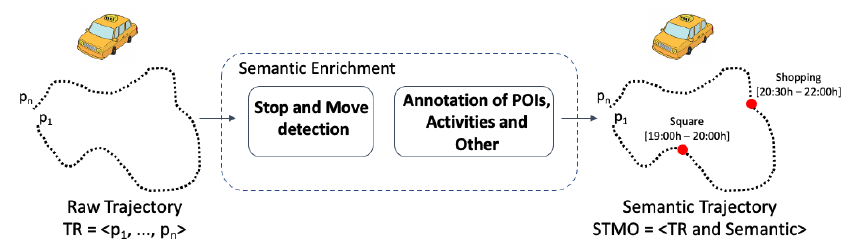
Figure 5. Example of semantic annotation